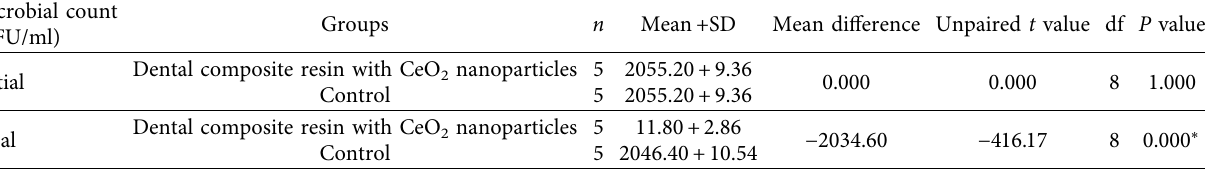
Table 4: Comparison of microbial count (CFU/ml) between the experimental group and control group for Streptococcus aureus . Microbial count (CFU/ml)